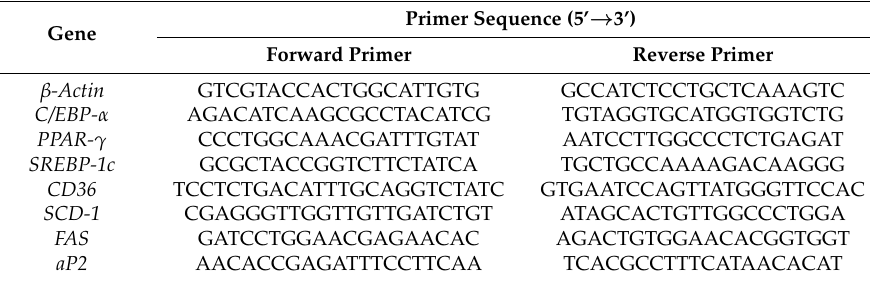
Table 2. Sequence of primers used in real-time PCR.